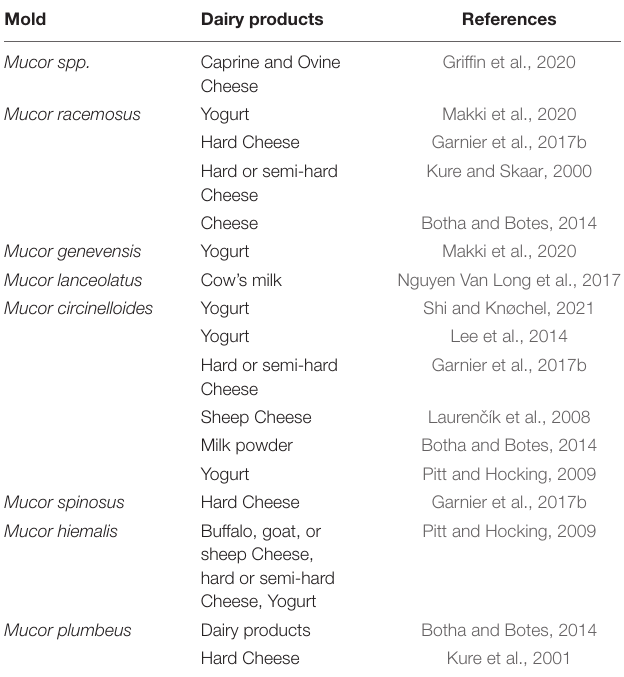
TABLE 2 | Diversity of spoilage Mucor strains isolated from contaminated dairy products. Mold Dairy